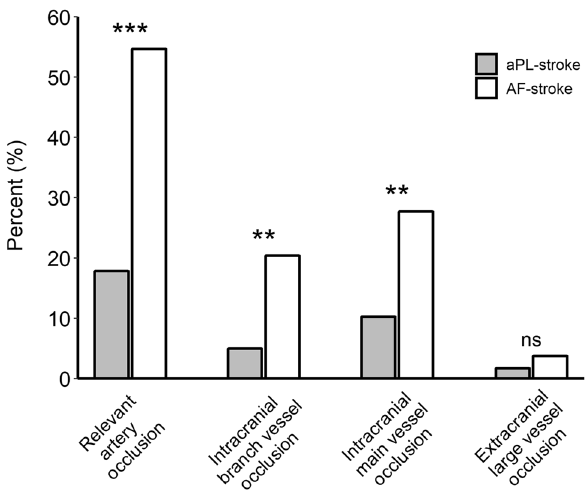
Figure 3. Proportion of patients who experienced relevant artery occlusion among aPL- and AF-stroke patients. Intracranial branch vessel occlusion, occlusion of the ACA, PCA, M2 or distal segments of the MCA, or SCA; intracranial main vessel occlusion, occlusion of the distal ICA, M1 segment of the MCA, distal VA, or BA; and extracranial large vessel occlusion, occlusion of the CCA, proximal ICA, or proximal VA. *** p < 0.001;